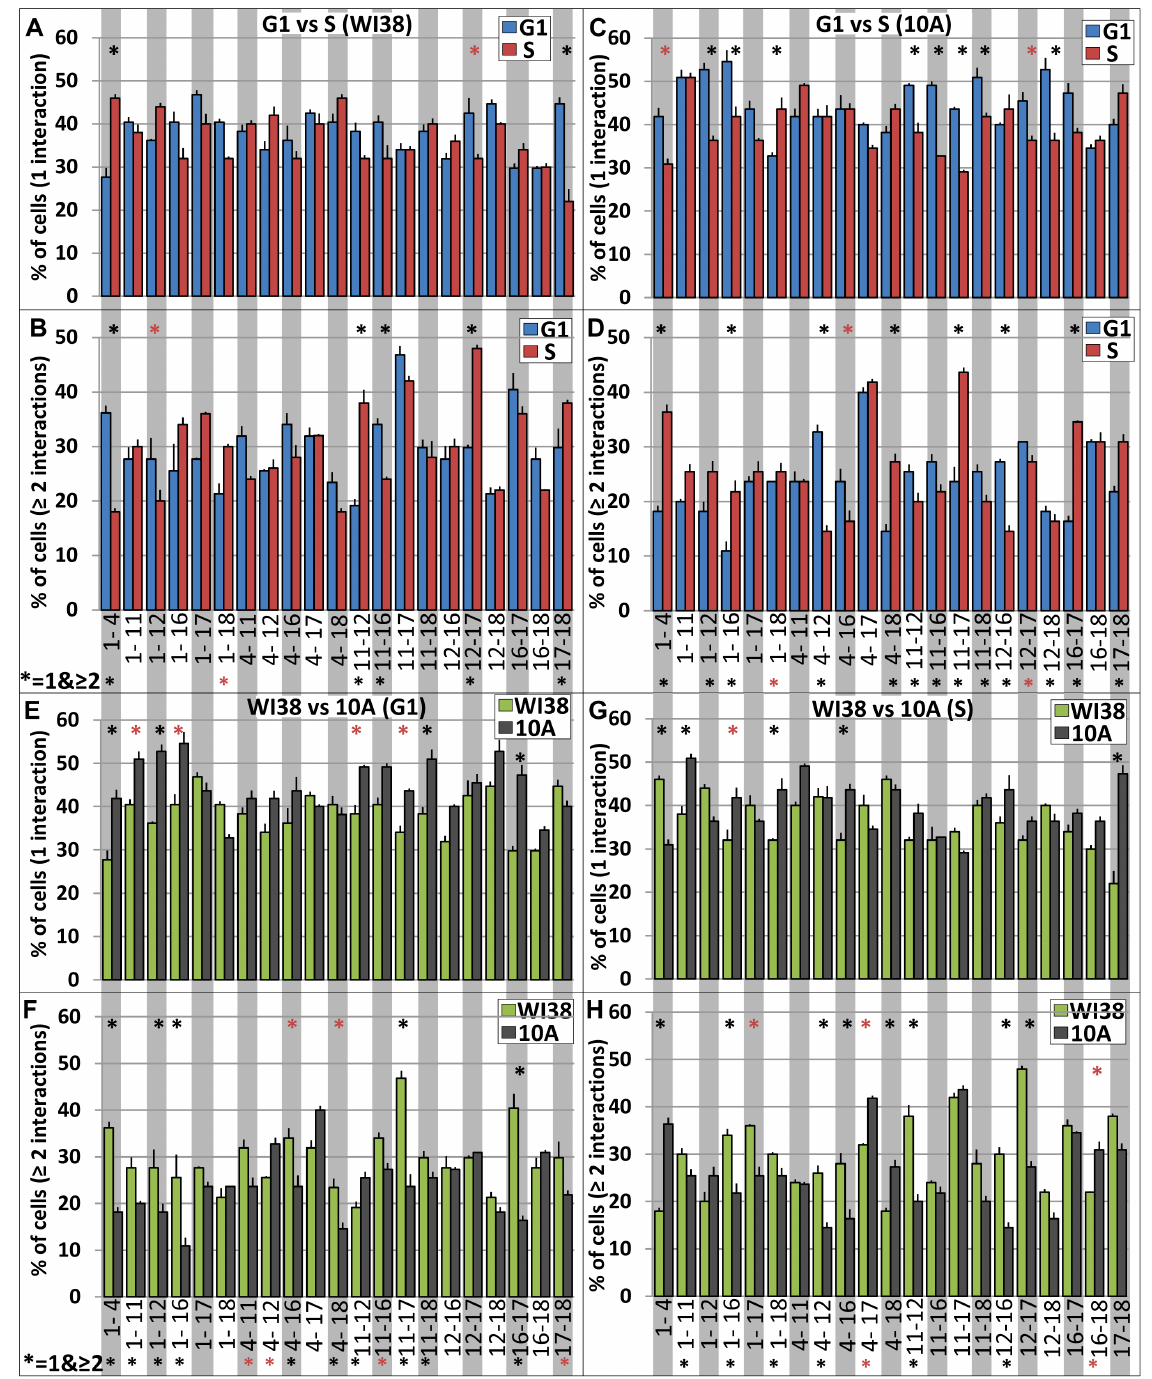
Figure 2. Interaction profiles of CT are altered across the cell cycle and cell types. Since each CT has two homologs there are four possible interactions in each nucleus. ( A–D ) Differences across the cell cycle- The percent of cells with only 1 interaction ( A ) and the percent of cells that have 2 or more interactions ( B ) in WI38 are shown for each of the 21 pairwise combinations of CT (G1, n=46; S, n=47). The percentage with only 1 ( C ) and 2 or more ( D ) in 10A are shown (G1, n=56; S, n=54); blue bars are G1 and red are S. ( E–H ) differences between cell types- The percent of cells with only 1 interaction ( E ) and the percent of cells that have 2 or more interactions ( F ) in G1 of WI38 and 10A are shown. The percent with only 1 ( G ) and 2 or more ( H ) in S of WI38 and 10A are shown, green bars are WI38 and black are 10A. error bars=SEM. Black asterisks indicate chi-square test, p , 0.05, while red indicate p , 0.10. Full p values are presented in Tables S3,S6.